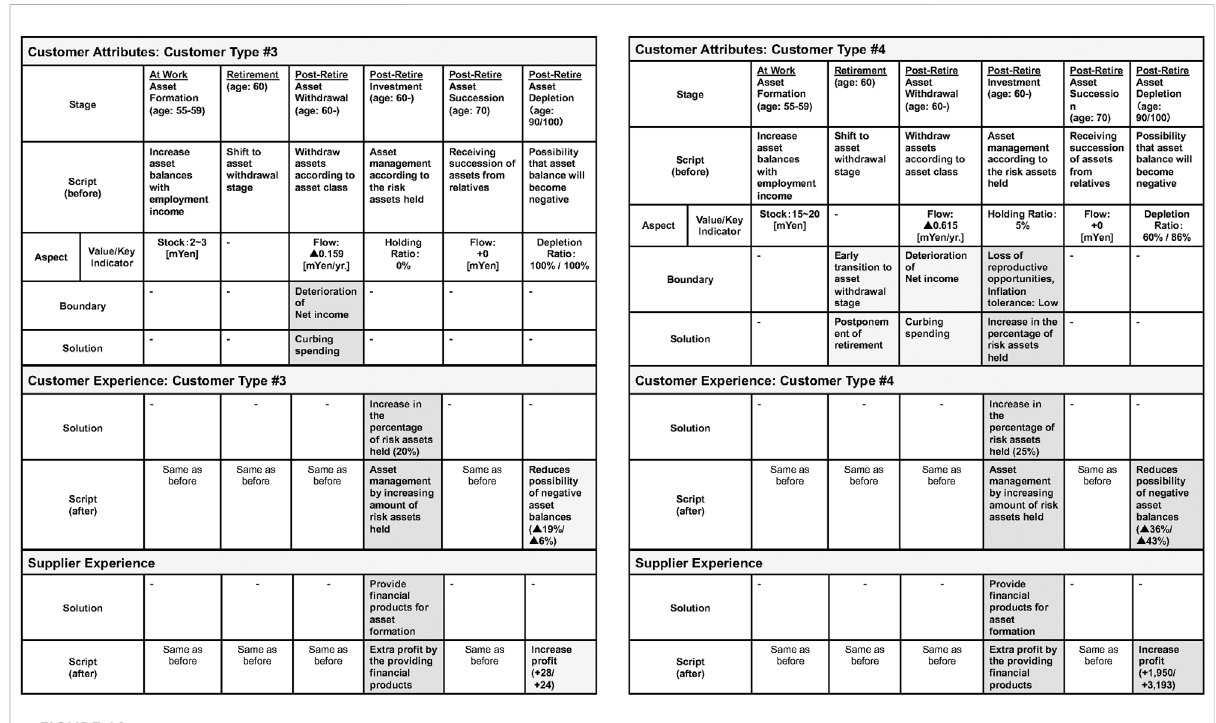
FIGURE 10 Simulation results described with extended SEBM (Customer type: #3, Right: Customer type: